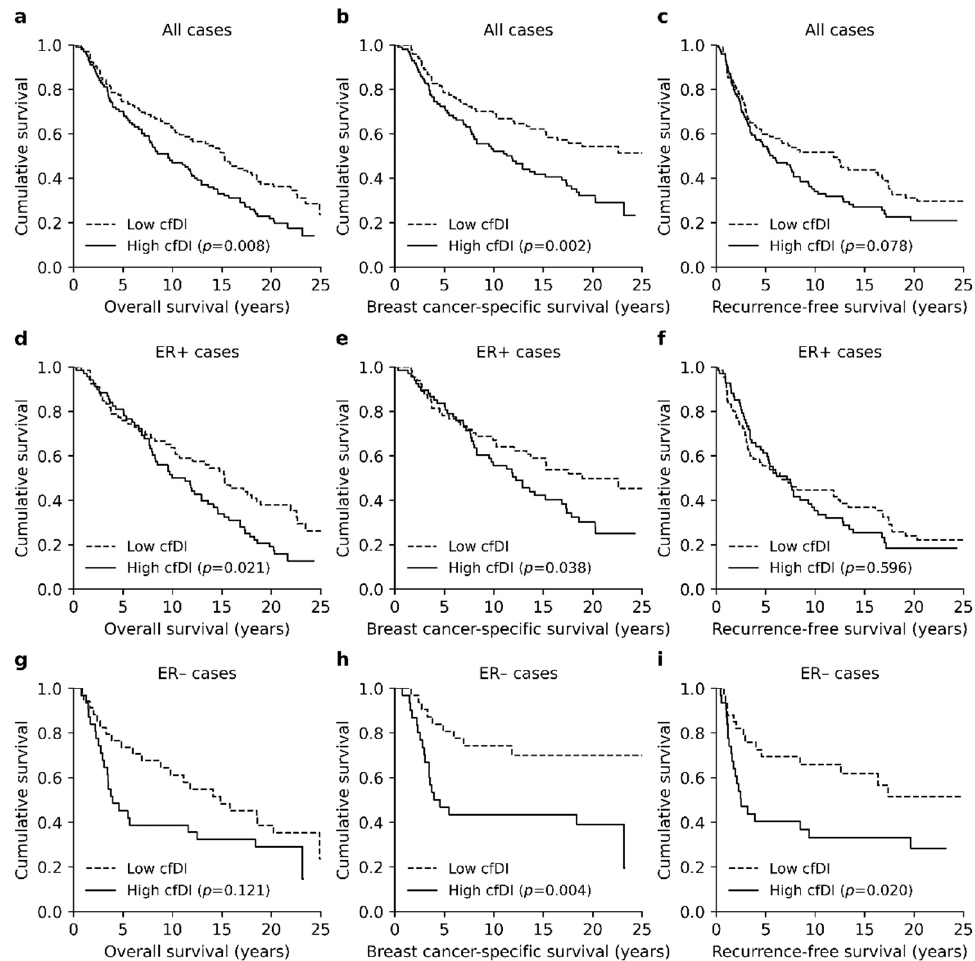
Figure 3. Kaplan–Meier plots representing the association between cfDI and survival. ( a ) High cfDI was associated with poor OS ( p = 0.002) and ( b ) BCSS ( p = 0.008). ( c ) The association with RFS was less prominent and only visible at the 10- and 15-year follow-ups ( p = 0.045 and p = 0.037). ( d , e ) In ER+ patients, high cfDI was associated with poor OS and BCSS, but ( f ) association with RFS was not observed. ( g ) In ER − patients, high cfDI was associated with poor OS and ( h ) poor BCSS at the 5- and 10-year follow-ups ( p = 0.024 and p = 0.045). ( i ) Association between high cfDI and poor RFS was the most prominent in ER − patients. All p -values were obtained by the Logrank test. Patients with ER+ BC had slightly higher median cfDI than ER − patients (0 . 64 ± 0 . 04 vs. 0 . 52 ± 0 . 07, p = 0.011, Mann–Whitney U). Further analysis did not find any explanatory Figure 4a) and BCSS ( p = 0.006, HR = 1.93, 95% CI 1.21–3.08, Figure 4b) when dividing pa- tients according to the median cfDI. The association with RFS was not prominent ( p = 0.478, Figure 4c). In the ER+ patient group, high cfDI was an independent prognostic factor for poor OS ( p = 0.002, HR = 2.22, 95% CI 1.34–3.68, Figure 4d), but the associations with BCSS and RFS were less prominent ( p = 0.128 and p = 0.705, Figure 4e,f). In the ER − patient group, high cfDI was associated with poor BCSS ( p = 0.088, Figure 4g) but remained non-significant in our analysis. Associations with OS and RFS were not notable ( p = 0.941 and p = 0.434, Figure 4h,i). In general, the survival of the ER − patients was explained mainly by the tumor stage and positive lymph node